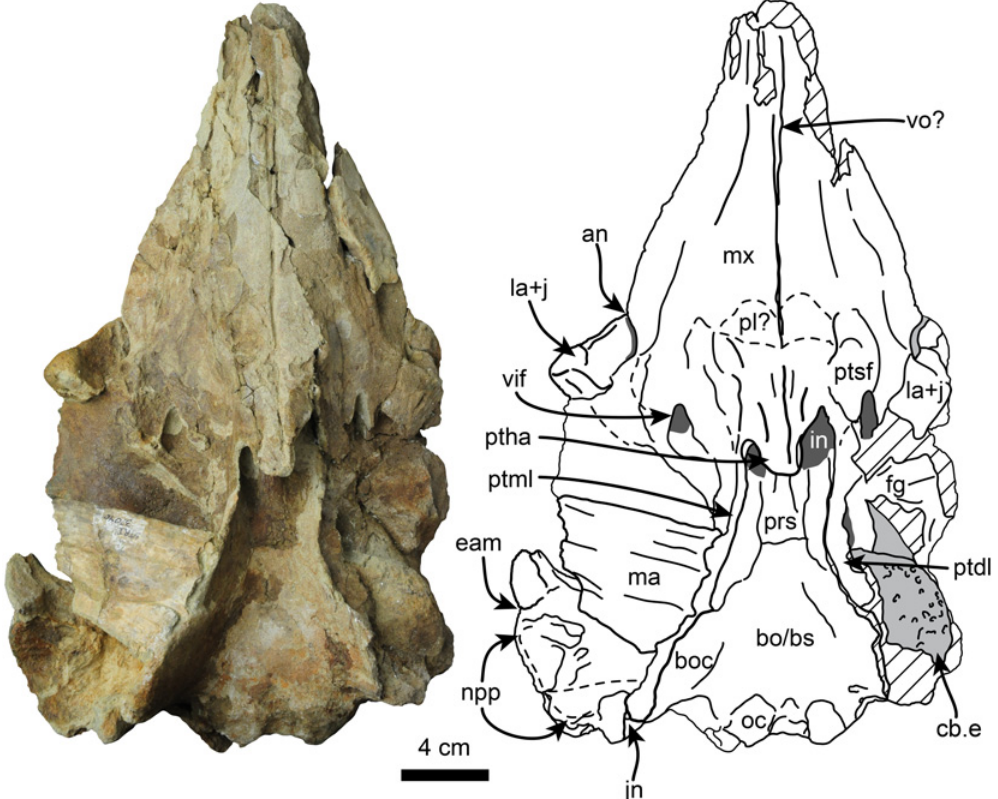
Fig 3. Ventral view of holotype skull of Nanokogia isthmia gen. et sp. nov. (UF 280000). Abbreviations: an, antorbital notch; bo/bs, basioccipital/ basisphenoid; boc, basioccipital crest; cb.e, cerebral endocast; eam, external auditory meatus; fg, frontal groove; in, internal nares; jn, jugular notch; la+j, lacrimal + jugal; ma, mandible; mx, maxilla; npp, notch for posterior process of tympanic; oc, occipital condyles; pl, palatine; prs, presphenoid; ptdl, dorsal lamina of pterygoid; ptha, pterygoid hamulus; ptml, medial lamina of pterygoid; ptsf, pterygoid sinus fossa; tsr, tympanosquamosal recess; vif, ventral infraorbital foramen; vo, vomer. Gray shaded areas indicate sediment; diagonal lines denote broken surfaces.